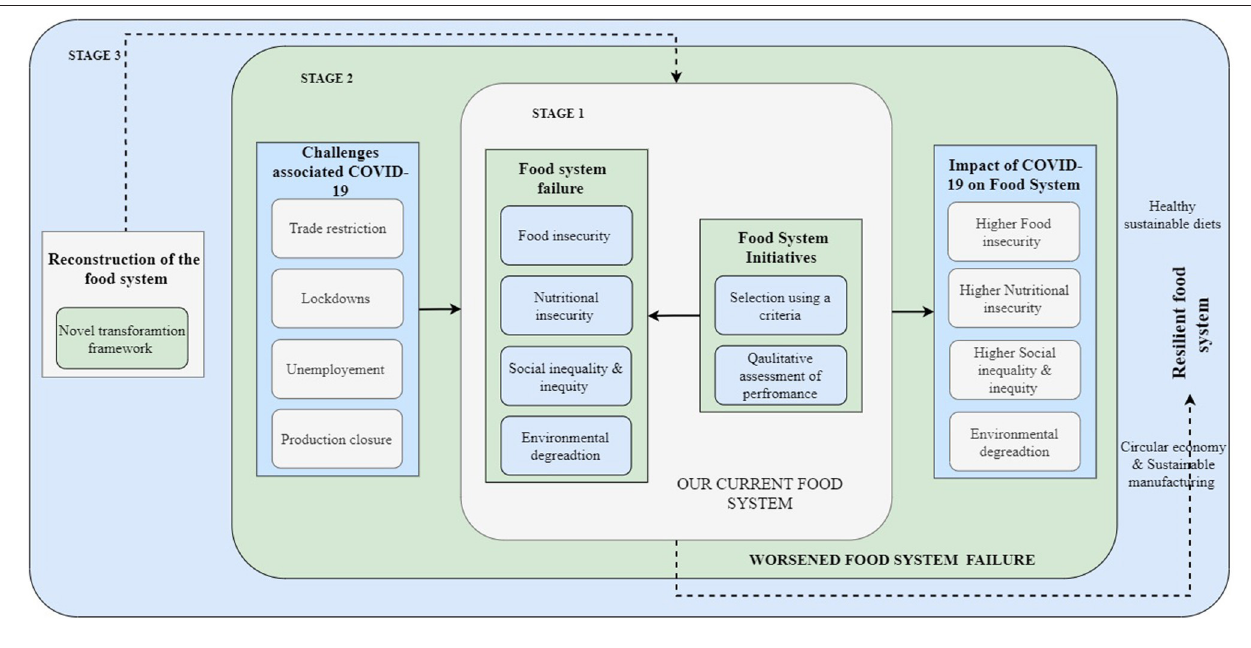
FIGURE 1 | Conceptual framework of the study.